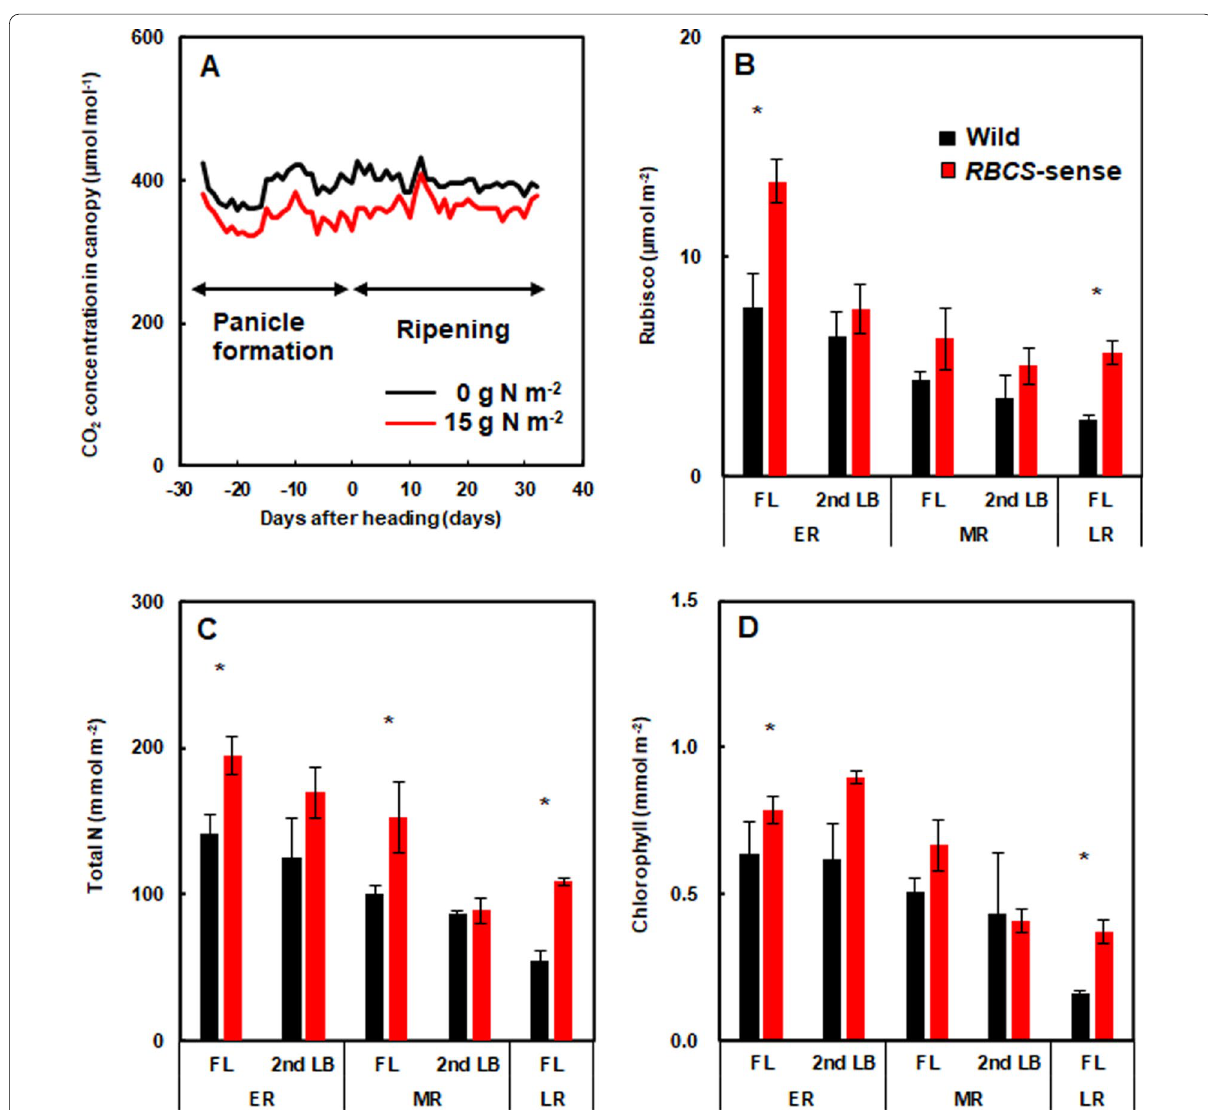
Fig. 2 Changes in CO 2 concentrations at airspace 10 cm below the top of the canopies of RBCS ‑sense rice plants throughout reproductive and ripening periods in the plots applied with 15 and 0 g N m − 2 fertilizer ( A ). Comparisons of Rubisco ( B ), total N ( C ), and Chl ( D ) contents per unit land area of flag leaves between wild‑type and RBCS ‑sense rice plants at the early, middle, and late stages of ripening period in the plots applied with 15 g N m − 2 fertilizer. The CO 2 concentrations in the canopies of the RBCS ‑sense rice plants were measured throughout 26 to 35 DAH as − reproductive and ripening periods ( A ). The flag and penultimate leaves of the wild‑type and RBCS ‑sense rice plants for measuring Rubisco, total N and Chl contents were harvested from 4 to 8 DAH in early, from 26 to 30 DAH in the middle, and 47 DAH in the late ripening stages ( B – D ). The arrows represent the reproductive (panicle formation) and ripening periods. Mean values the standard error of 3–5 independent of the flag ± leaves and penultimate leaf blades of wild‑type and RBCS ‑sense rice plants, respectively. * p < 0.05 between the wild‑type and RBCS ‑sense rice plants using Student’s t- test. The abbreviations stand as follows: “Chl”; chlorophyll, “DAH”; days after heading, “ER”; early ripening stage, “FL”; flag leaves, “LR”; late ripening stage, “MR”; middle ripening stage, “PL”; penultimate leaf blade, “ RBCS ‑sense”; transgenic rice plants overproducing Rubisco,